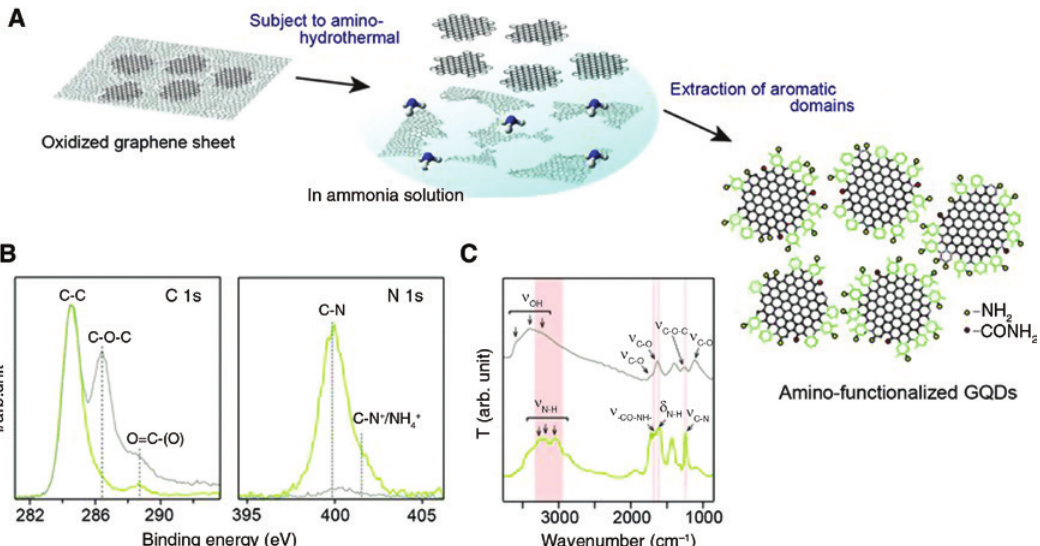
Figure 5: The hydrothermal strategy for the production of amino-functionalized GQDs (af-GQDs) by Tetsuka et al. [42]. (A) Schematic illus- tration of the preparative strategy for af-GQDs. (B) C1s and N1s X-ray photoelectron spectra for af-GQDs prepared at 90 ° C (green line) and OGS (gray line). (C) Transmission infrared-absorbance spectra of af-GQDs prepared at 90 ° C (green line) and OGS (gray line) (reprinted/repro- duced with the permission of Ref. [42], copyright 2012, Wiley-VCH Verlag GmbH &